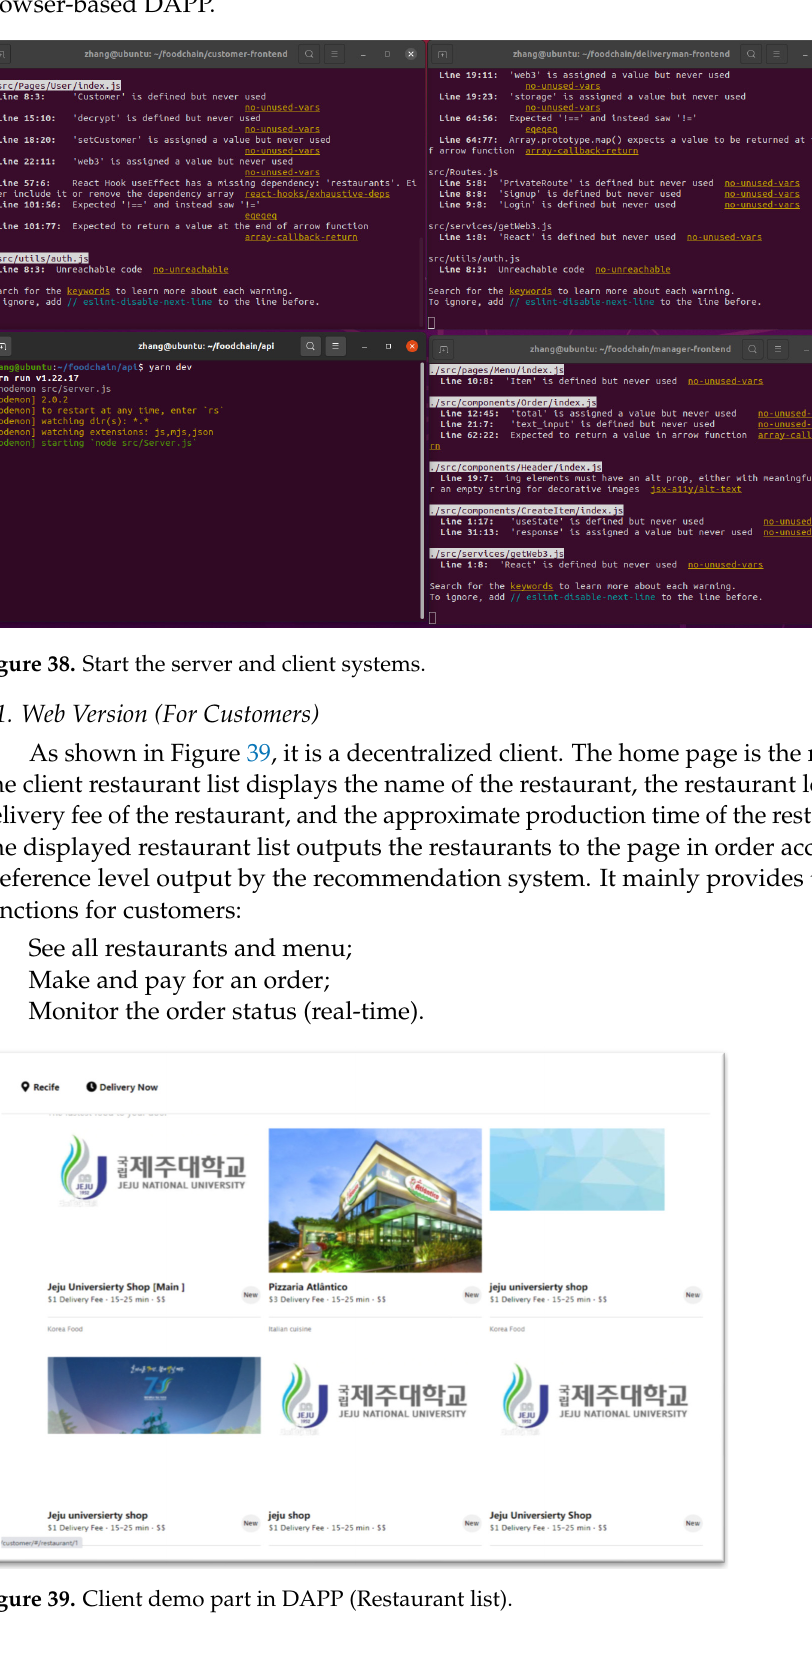
Figure 37. Recommend 5 restaurants for customer ratings.